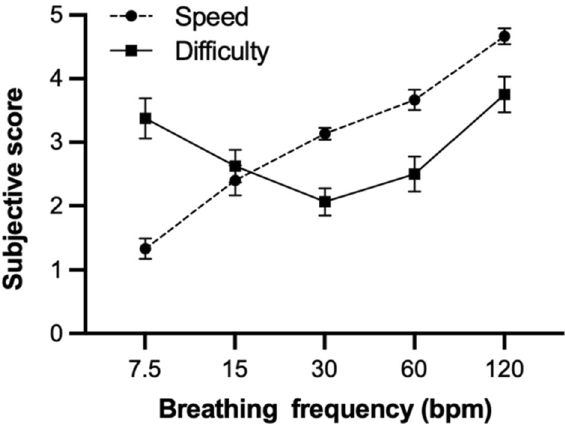
Figure 1. Subjective speed and difficulty scores. Vertical bars represent between-subject standard error.